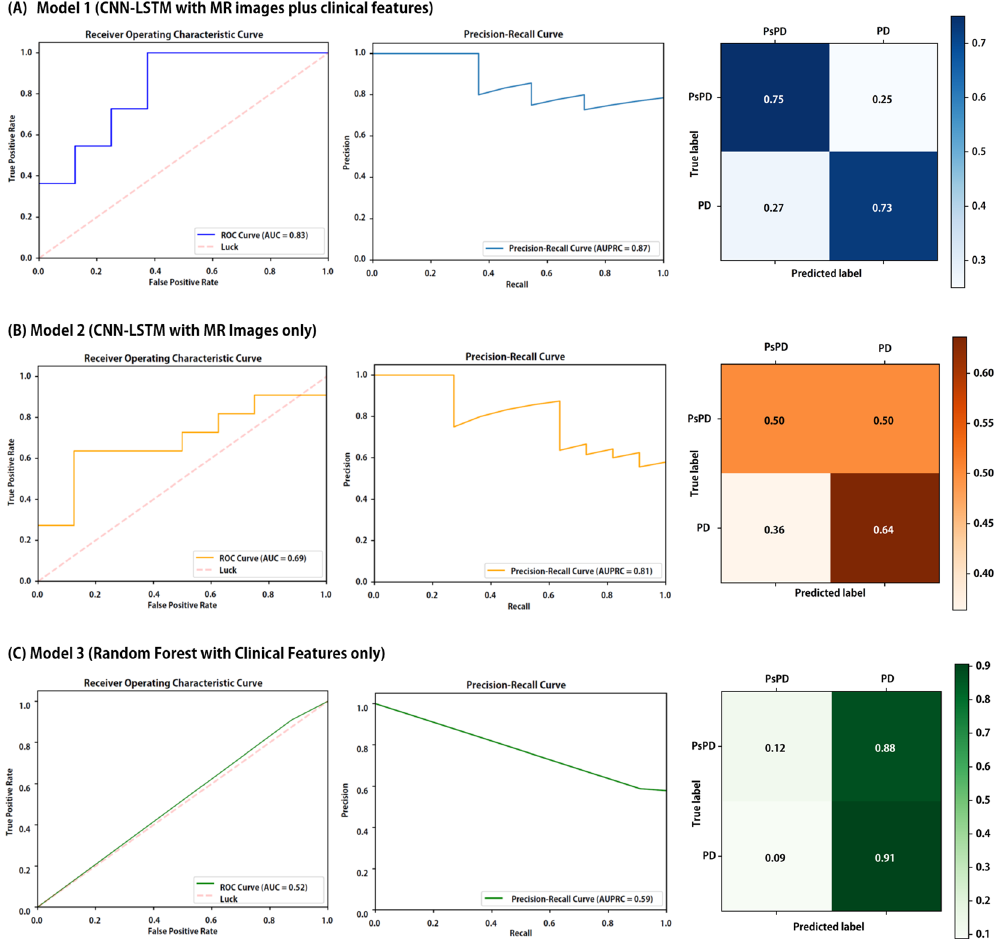
Figure 4. Summarized testing results comparing finalized ( A ) Model 1, ( B ) Model 2, and ( C ) Model 3 in the testing set (N = 19). Receiver operating characteristic curves (left) and precision-recall curves (middle) were depicted and area under the ROC curve (AUC) and area under the precision-recall curve (AUPRC) values were estimated. Normalized confusion matrix (right) also derived. The diagonal number denotes the normalized number of cases where the predicted label is equal to true label. Abbreviations: PD, progression; PsPD, pseudoprogression; AUC, area under the curve of ROC curve; AUPRC, area under the precision-recall curve.